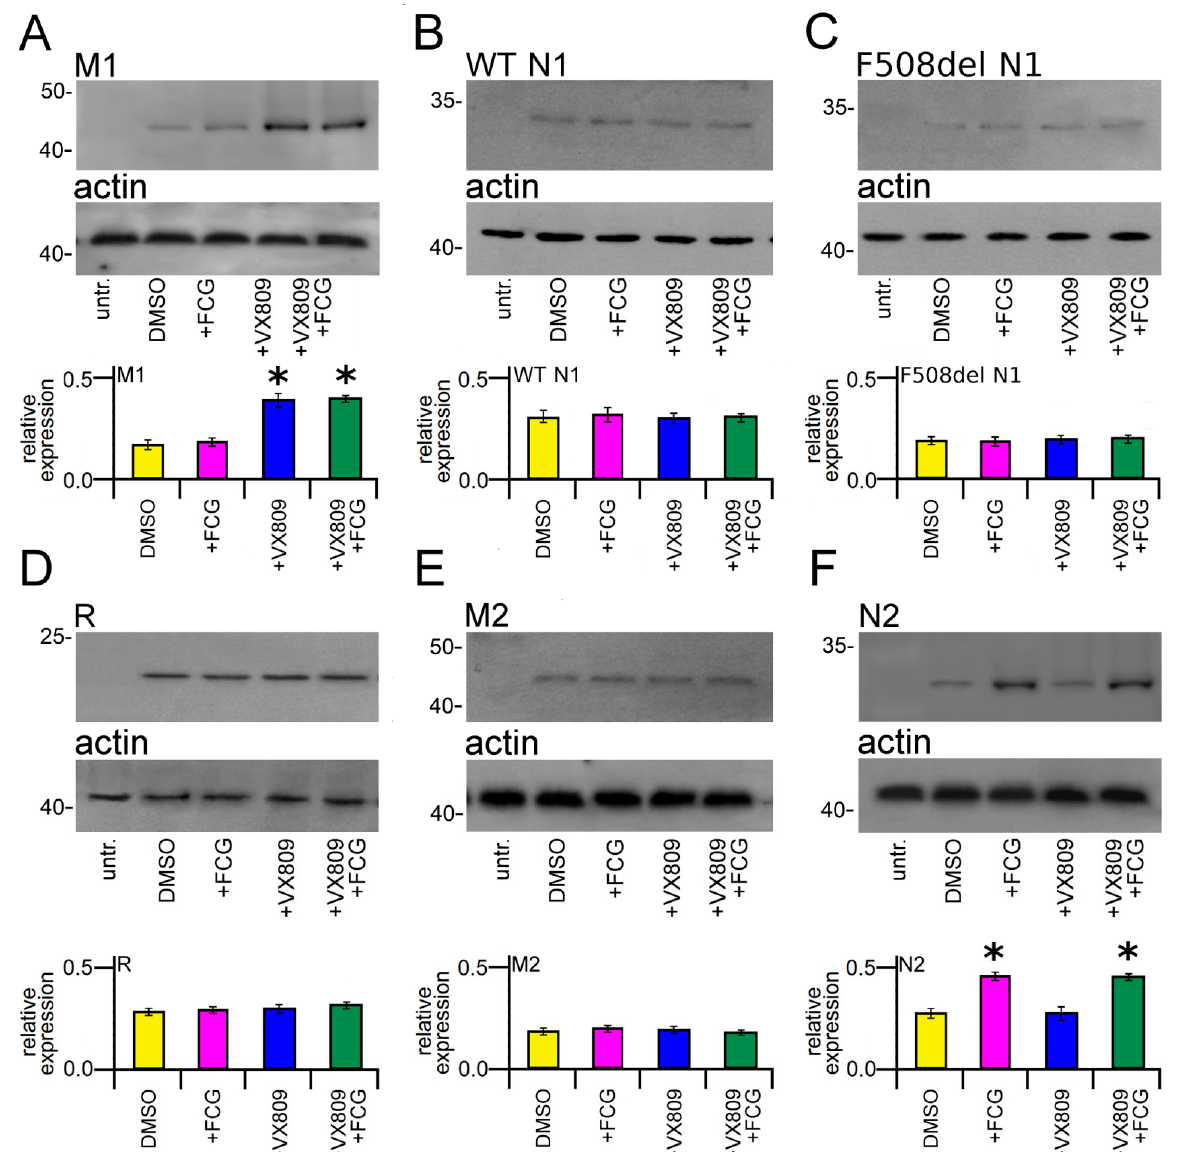
Figure 2. Effect of FCG, VX809, and FCG + VX809 on the expression of CFTR single domains. Western blots of M1 ( A ), WT ( B ) and del508F N1 ( C ), R ( D ), M2 ( E ) and N2 ( F ) CFTR domains in untransfected and in transiently transfected in HEK-t cells treated with DMSO (control) or with 10 µ M FCG, 5 µ M VX809, and 10 µ M FCG + 5 µ M VX809, respectively. In the lower blots is shown the expression of actin, used as housekeeping protein. The molecular weight of the proteins of the molecular weight marker that was run in the SDS-PAGE is indicated on the left of each blot. The bar graphs on the bottom of each panel indicate the normalized expression level of each single domain. Data are expressed as mean ± standard error of the mean (sem) of at least four independent experiments. Dunnett’s test was used for data comparison. Asterisks indicate a statistical significance versus control: * p < 0.05.